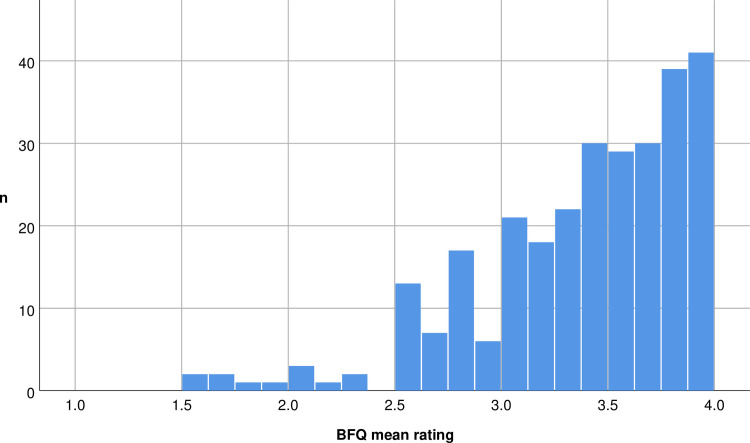
The strongly left-skewed distribution of the mean BFQ item ratings across participants: The mean item rating across participants was 3.41 (SD 0.51); the individual data can be retrieved from Figs 2 to 4.